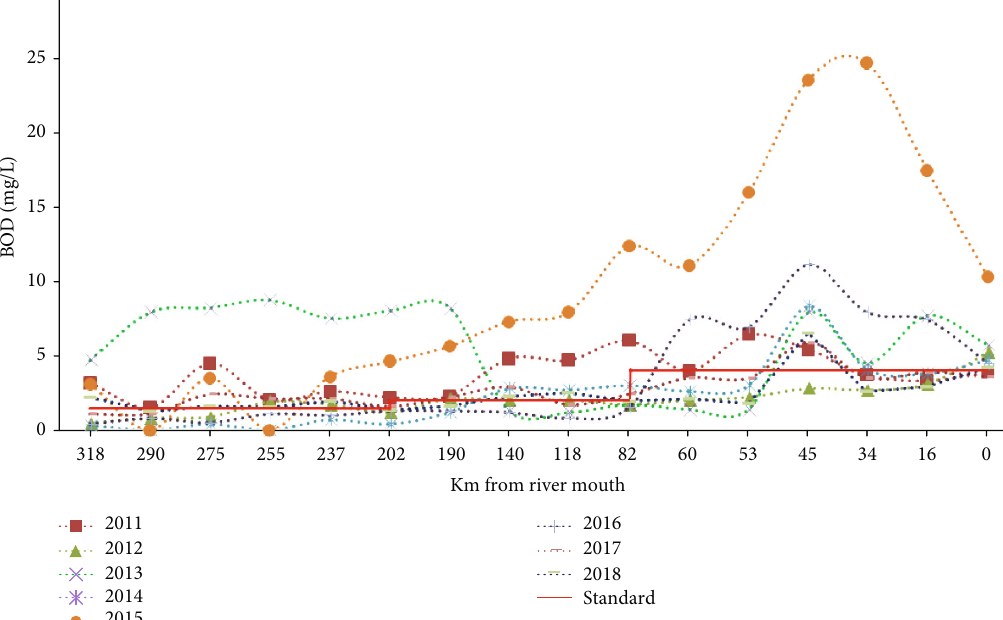
Figure 1: BOD status in the Tha Chin river (April-June) during 2011-2018. (Modi fi ed from raw data which is available from